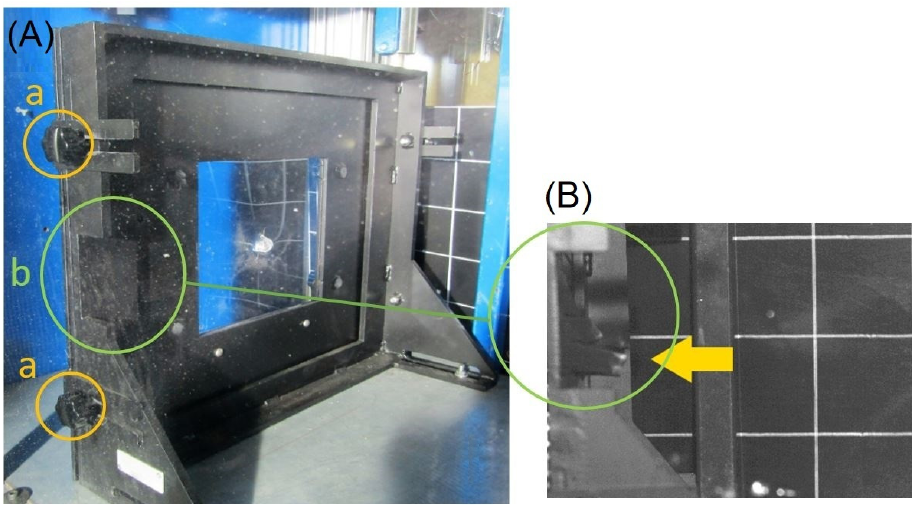
Figure 4. ( A ) Clamping and support system: (a) clamping device, (b) window for camera view. ( B ) Camera framing.